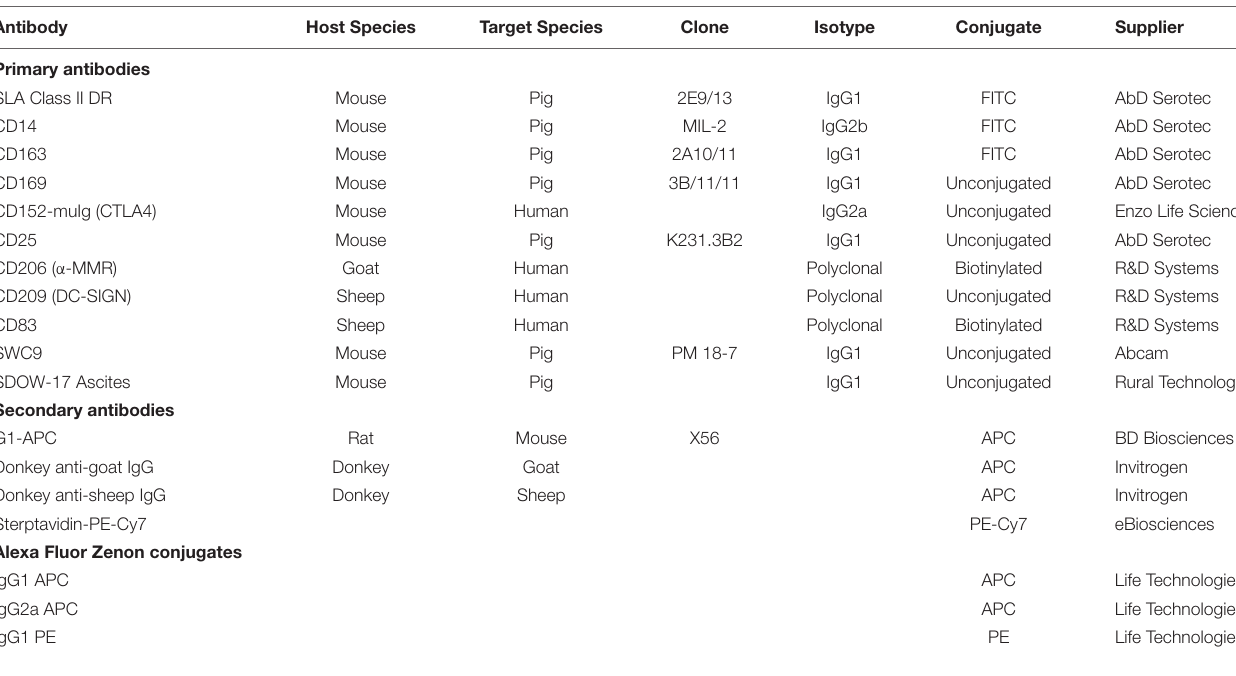
TABLE 1 | Table of